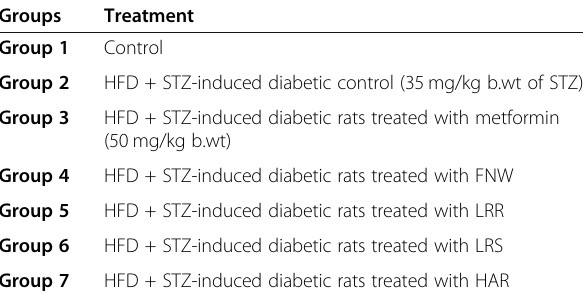
Table 3 Experimental design for in vivo anti-diabetic study with high-fat diet